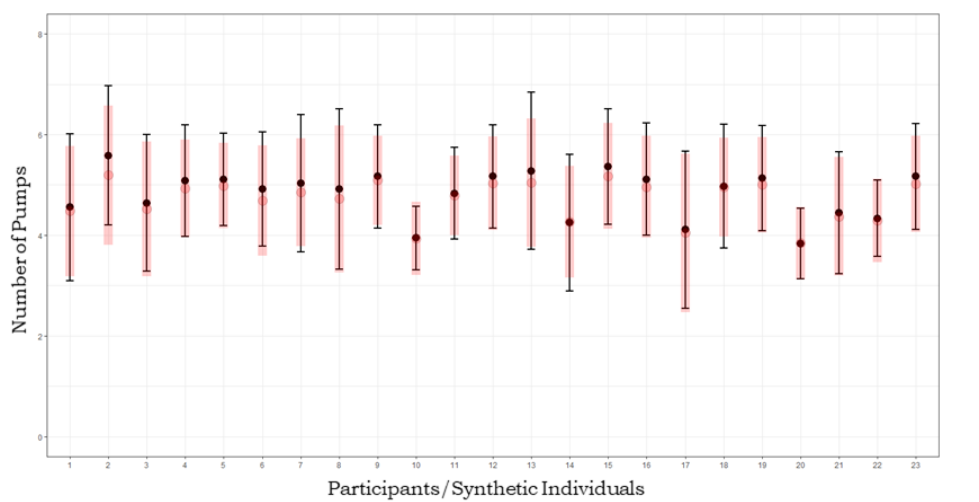
Figure 4. Posterior predictive check. Black dots and boundaries represent mean pumps and standard deviations for each individual from the empirical dataset. Red dots and lines represent mean pumps and standard deviations of predicted synthetic individual